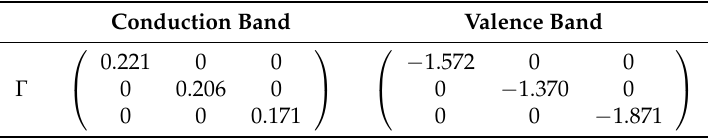
Table 2. Calculated effective electron mass ( m e* ) and hole mass ( m h * ) along the three principal directions at the Γ point. All values are in units of free electron mass ( m 0 ).